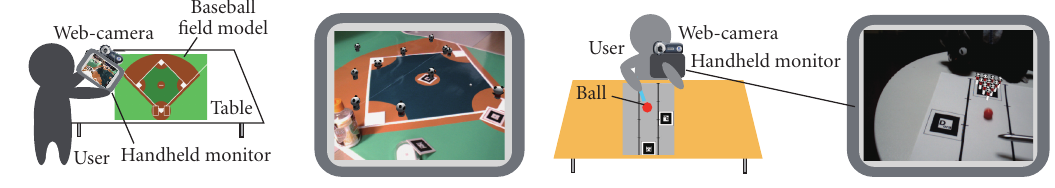
Figure 1: Our proposed AR applications.